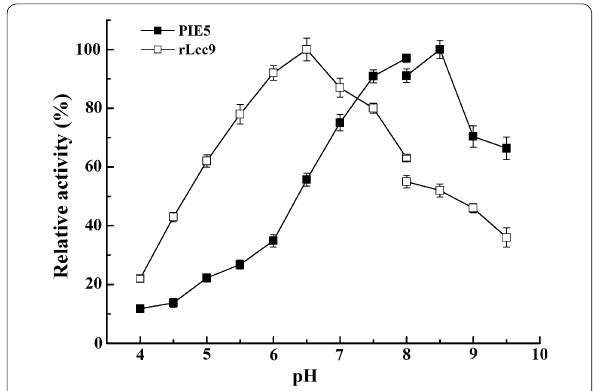
Fig. 1 The pH profiles of PIE5 and rLcc9 towards guaiacol. The data presented are the average values from triplicate parallel experiments and technical repeats of measurements (n =